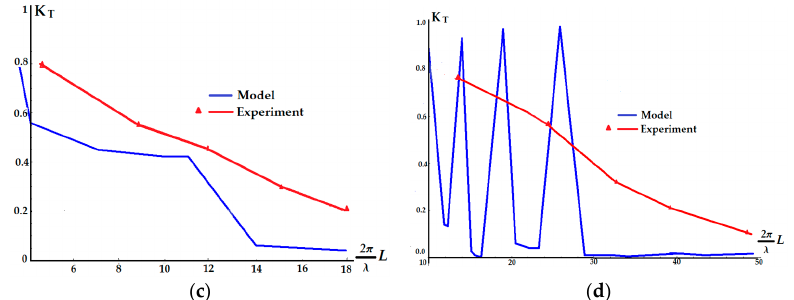
Figure 15. Wave transmission coefficient K T = H T / H I in dependence of (2 π L / λ ) ratio for different plate materials ( a ) latex, length of plate L = 1.9 m, β ∼ 5.6 × 10 − 6 . ( b ) polyvinyl chloride (PVC), length of plate L = 1.9 m, β ∼ 0.02 ( c ) steep cotton, length of plate L = 1.9 m, β ∼ 5 × 10 − 3 . ( d ) latex, length of plate L = 5.1 m. For all cases depth of water a = 0.3 m, thickness of plate H w = 0.02 m. Red lines and triangles (experimental points) correspond to experiments, blue lines–to results of numerical simulations of the model.